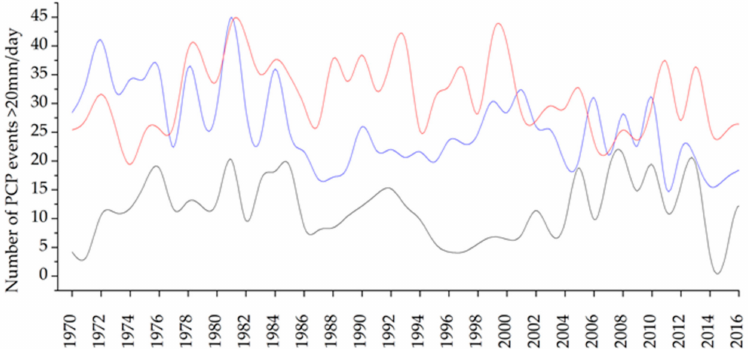
Figure 4. Number of yearly precipitation events above 20 mm / day for the Panuco (black line), Papaloapan (blue line), and Coatzacoalcos (red line) basins for the period